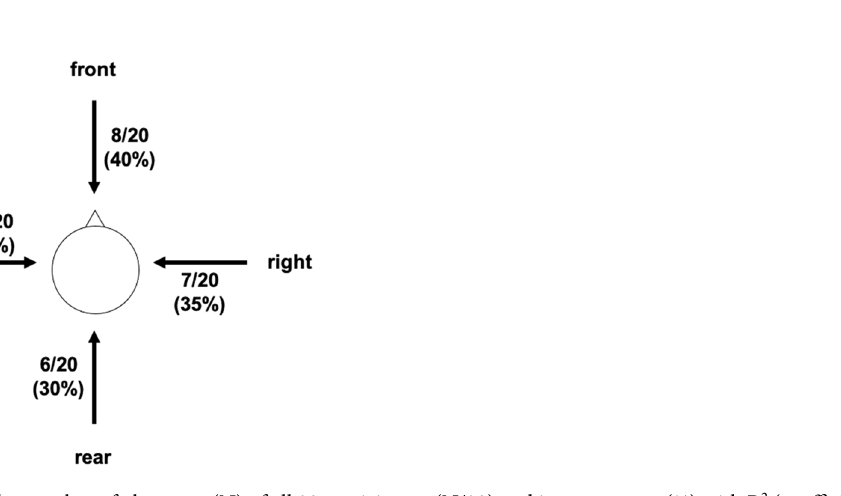
Figure 4. The number of observers (N) of all 20 participants (N/20) and its percentage (%) with R 2 (coefficient of determination for the sigmoidal function) higher than 0.5 for each body-relative direction for the approaching sound condition. The results of Table 1 and these results, taken together, imply that the PPS in the front and left directions might be stronger while the PPS of the rear might be